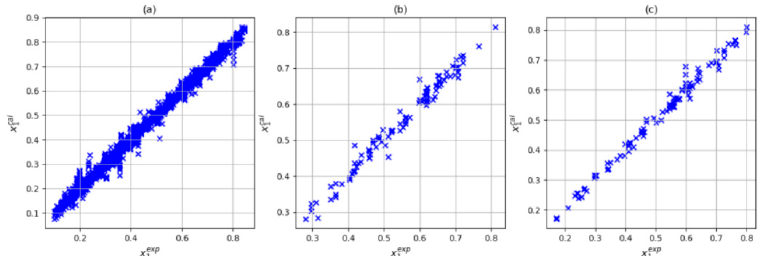
Figure 6. Correlation between experimental data and those calculated by ANN using T, P, Tc, Pc, and ω inputs with (5,6,8,1) architecture: ( a ) training dataset, ( b ) testing dataset, and ( c ) prediction dataset.